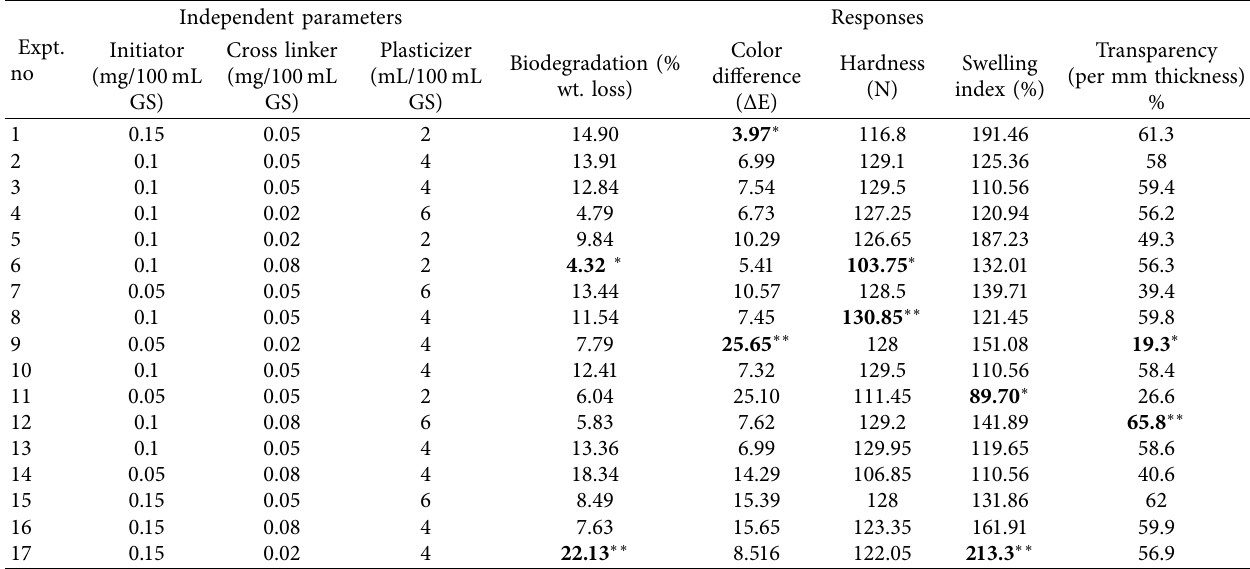
Table 3: Experimental results of response for the development of hydrogel film.